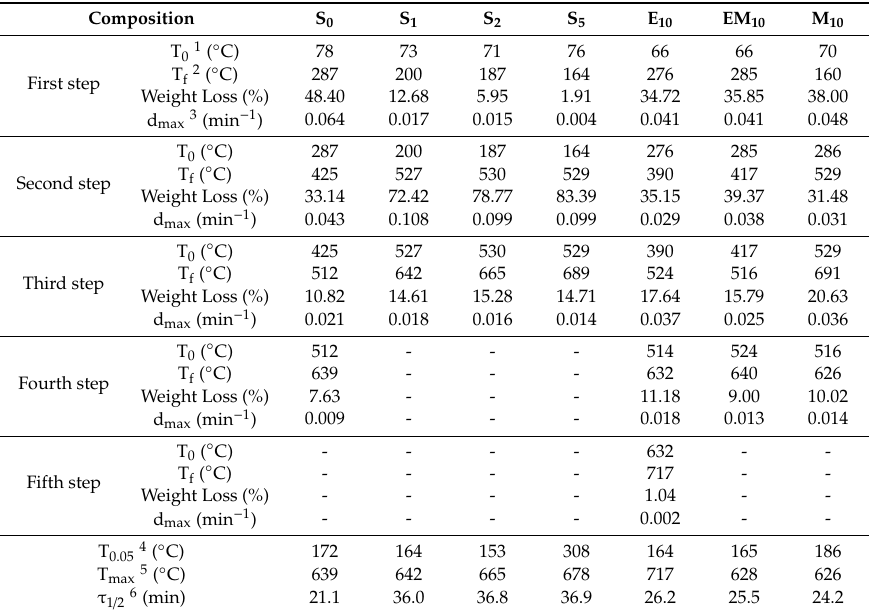
Table 3. Thermalgravimetric parameters of epoxy